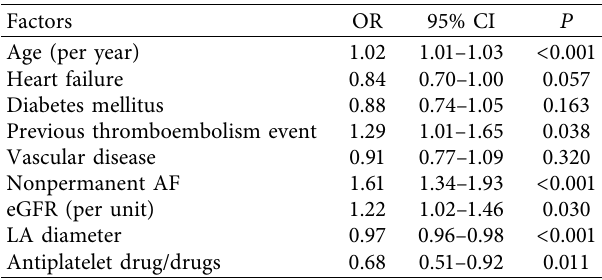
Table 3: Factors increasing the chances of using non-vitamin K antagonist oral anticoagulant in analysed patients—multivariate logistic regression